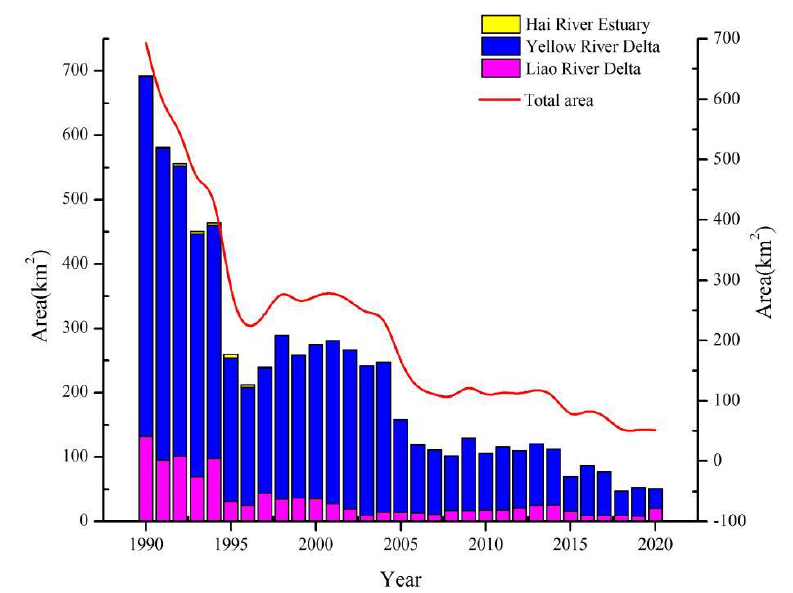
Figure 5. Dynamic changes in the S. salsa areas for each year.